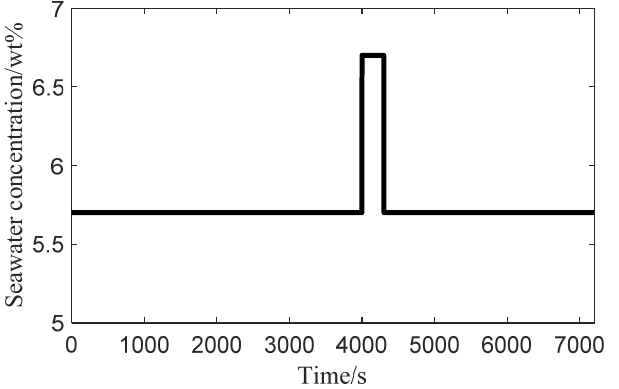
C C F . . Figure 17. Disturbance of the decrease in